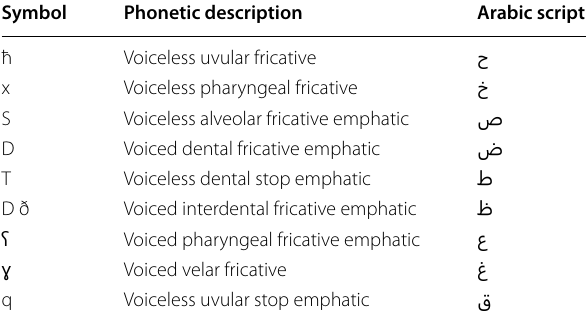
Table 2 Phonetic description of distinctive Arabic sounds